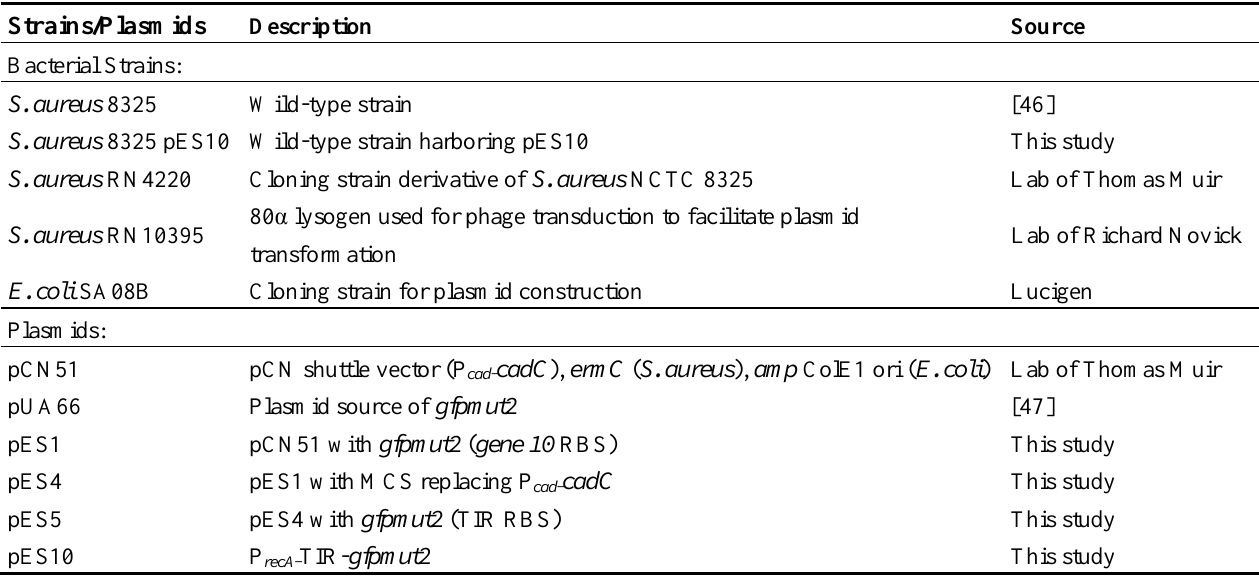
Table 1. Strains and plasmids used in this